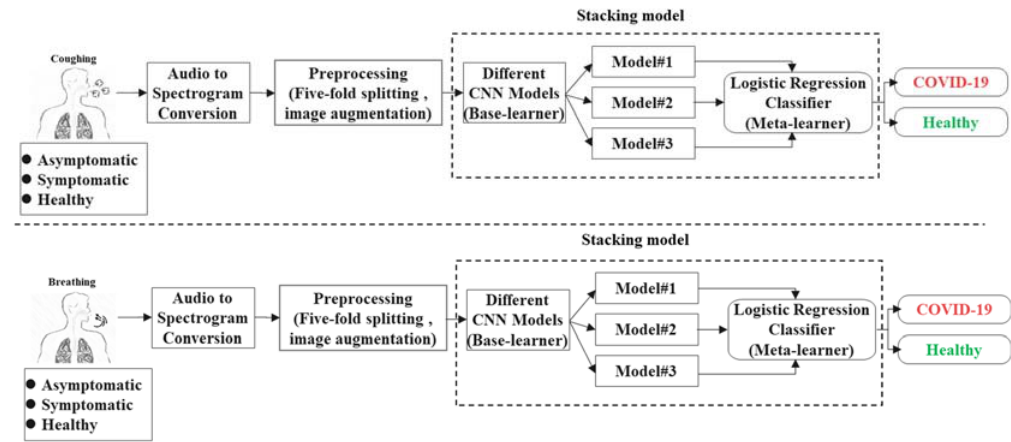
Figure 1. Methodology of the study.